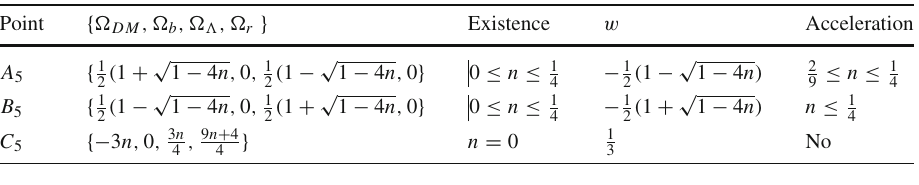
stability for Case E